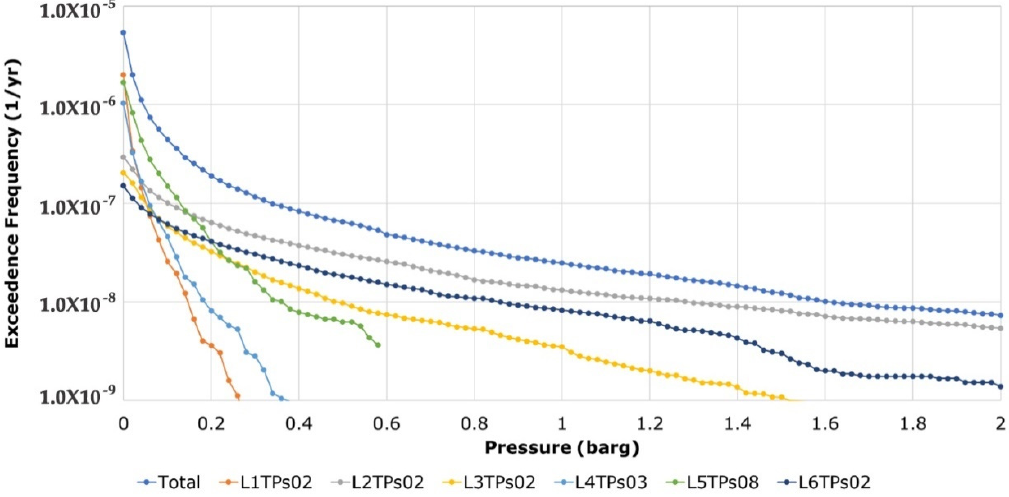
Figure 16. Exceedance frequency curves on PR1_1st deck. (2)